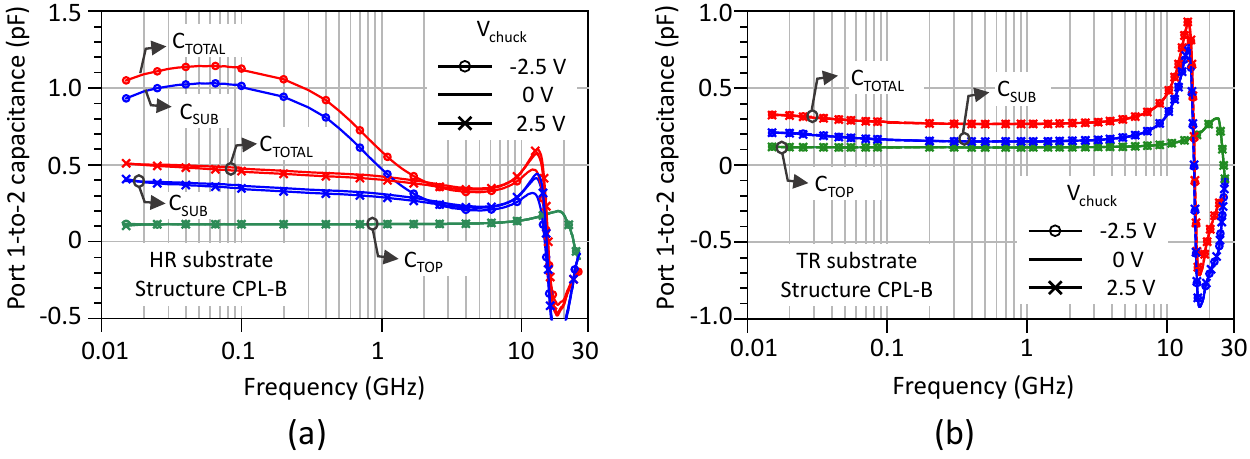
Figure 6. Coupling capacitances between the electrode combs of structure CPL-B at chuck bias of − 2.5, 0 and 2.5 V. C TOTAL is the total measured capacitance, C TOP is the capacitance mainly associated with the interconnects, C SUB represents the contribution of the substrate to the lateral capacitive coupling. ( a ) HR starting substrate; ( b ) TR starting substrate.